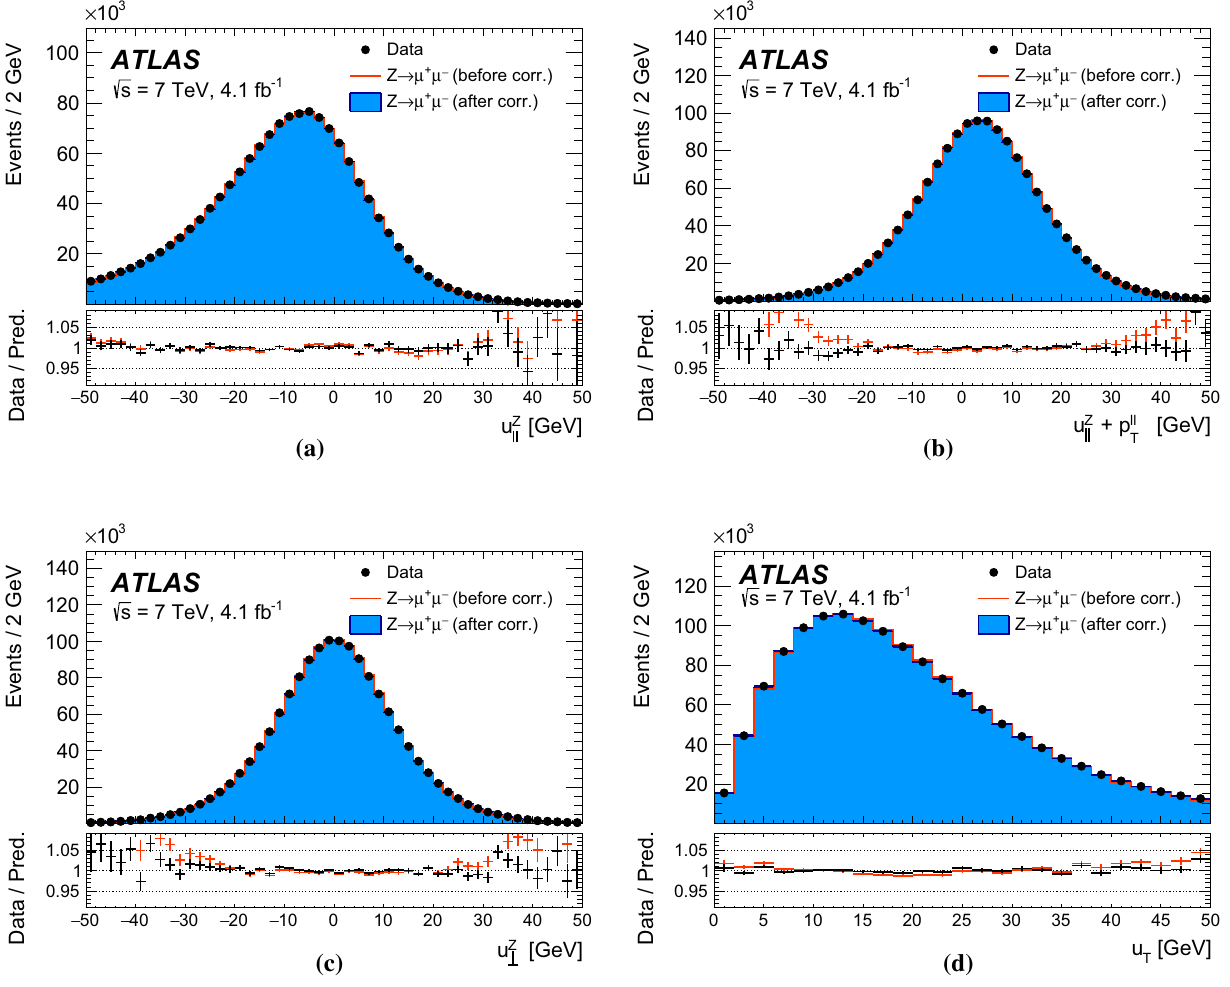
Fig. 12 Recoil distributions for a u Z (cid:5) , b u Z (cid:5) + p (cid:7)(cid:7) , (c) u Z ⊥ , and (d) u T in Z → μμ events. The data are compared to the simulation before and T after applying the recoil corrections described in the text. The lower panels show the data-to-prediction ratios, with the vertical bars showing the statistical